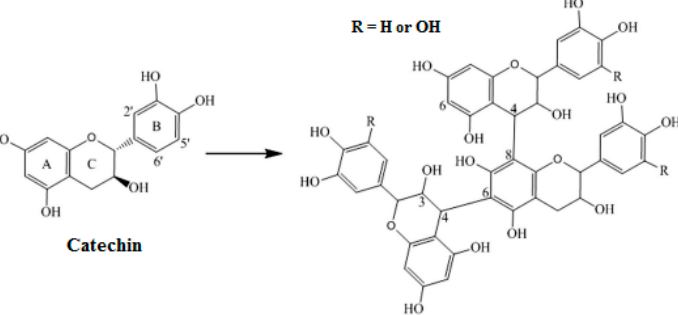
Figure 8. Polymerization of catechin monomer to a general structure of condensed tannins.